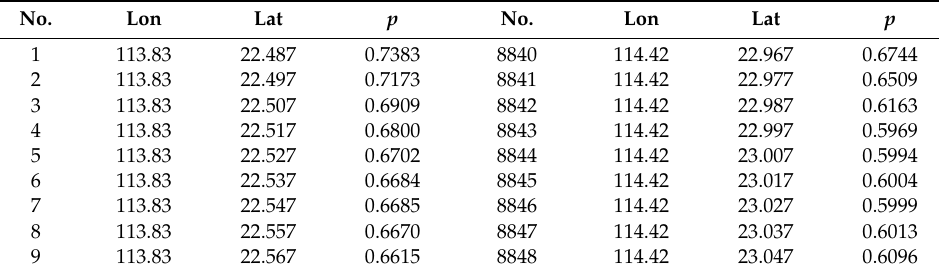
Table 6. Partial damage probability results of